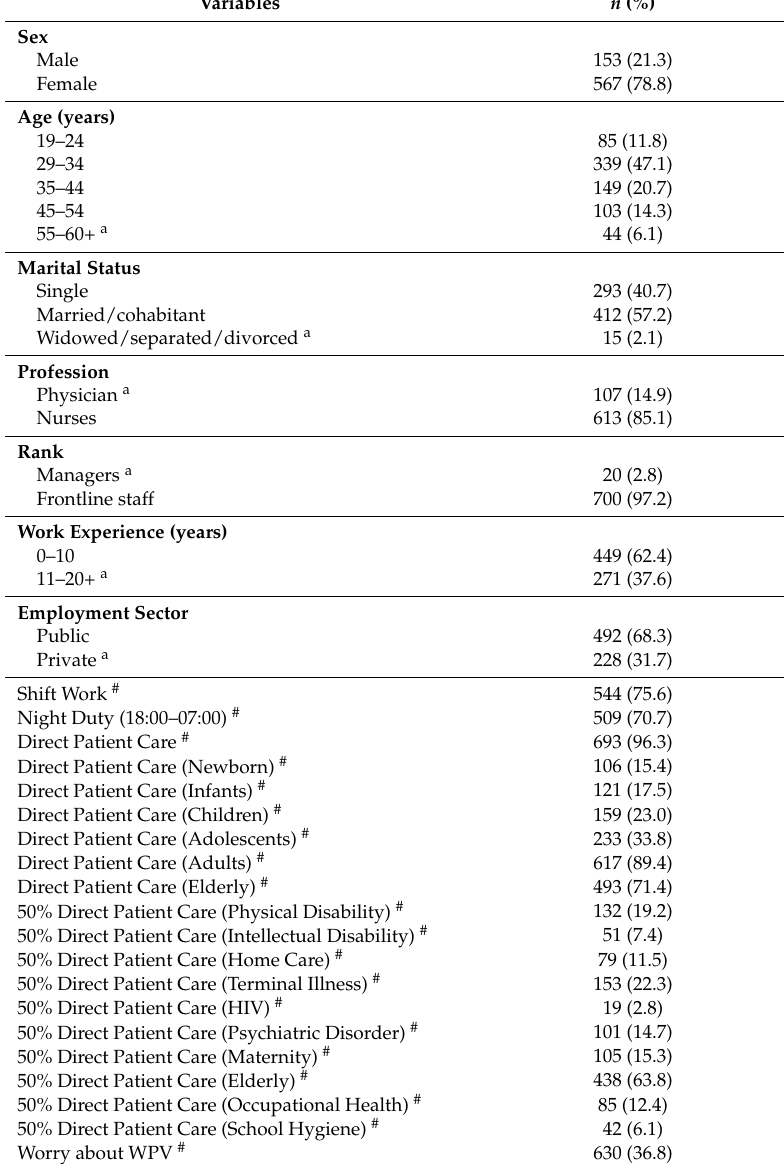
Table 1. Frequency distribution of respondents by socio-demographic characteristics and selected variables ( n =